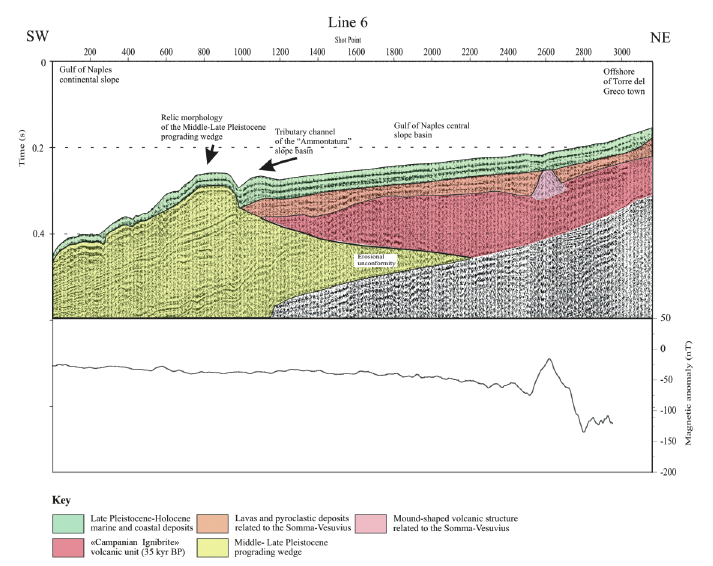
Fig. 6. Seismic profile GP31 and corresponding interpretation. The relative magnetic profile is reported in the inset. No magnetic anomaly occurs in the seismic units interpreted as the Middle-Late Pleistocene sedimentary basin filling of the Gulf of Naples continental slope (see the left part of the profile). Offshore the Somma-Vesu- vius volcanic complex a magnetic anomaly whose value is in the order of 120 nT corresponds to a dome-shaped volcanic structure warping the Campanian Ignimbrite pyroclastic flow